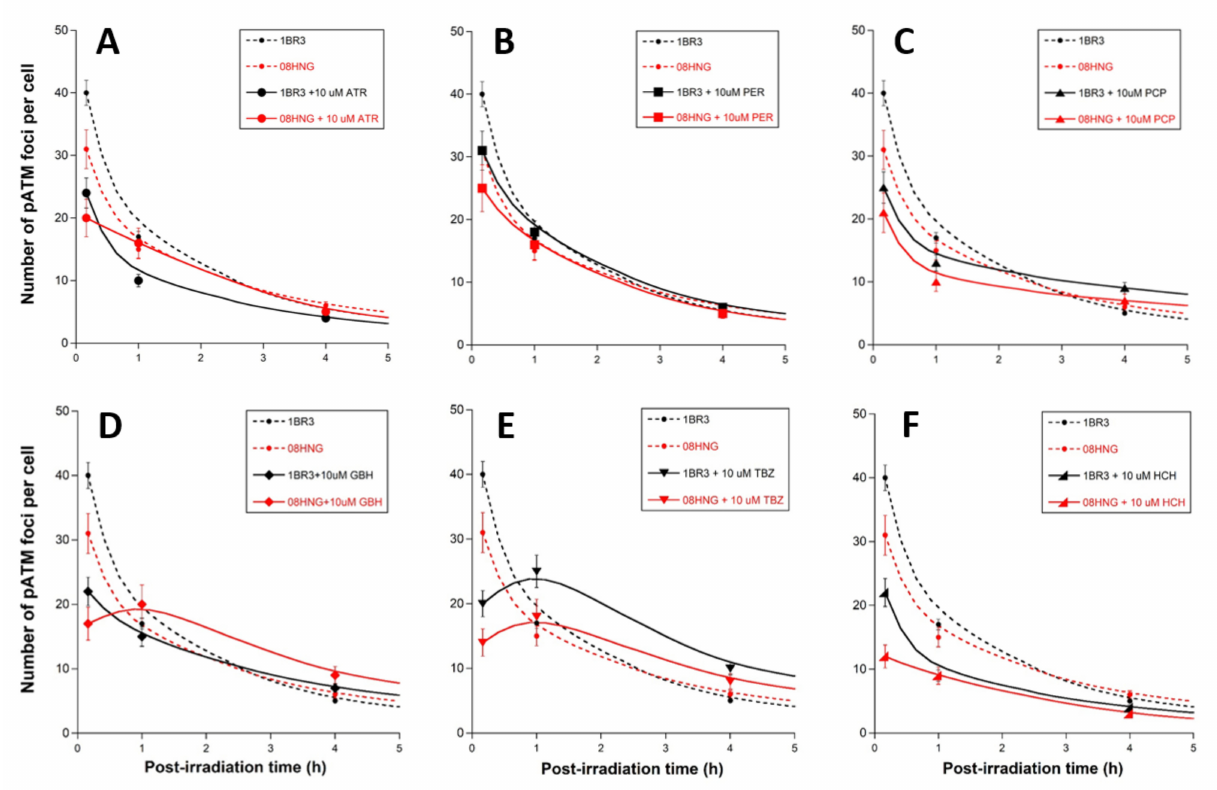
Figure 6. pATM foci kinetics after exposure to pesticide and X-rays. Number of γ H2AX foci as a function of post-irradiation time in the human untransformed radioresistant RIANS-normal 1BR3 (black plots) and RIANS-delayed 08HNG (red plots) fibroblasts incubated for 24 h with the indicated concentrations of pesticides (solid line) or not (dotted line) and irradiated (2 Gy X-rays) thereafter (( A ): ATR; ( B ): PER; ( C ): PCP; ( D ): GBH; ( E ): TBZ; ( F ): HCH). Each plot represents the mean ± standard error (SEM) of three replicates. It is noteworthy that the 24 h data were not found to be dependent on the presence of pesticides before